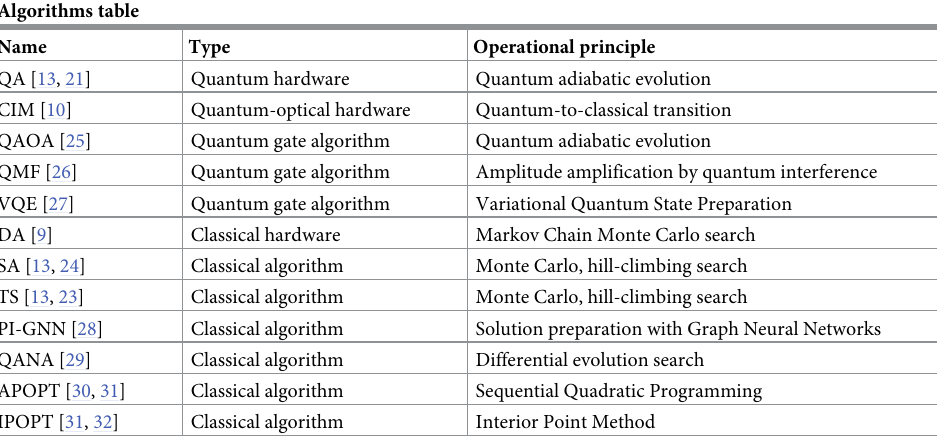
Table 1. The summary of quantum and classical algorithms that support the proposed mathematical